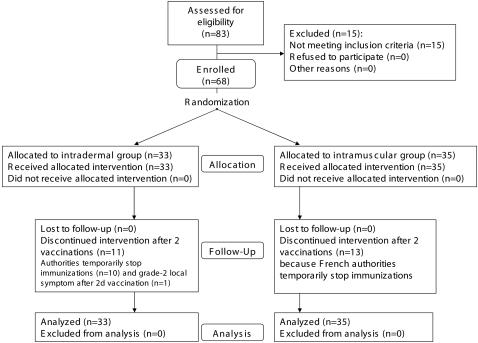
ANRS VAC16 Participant flow chart.